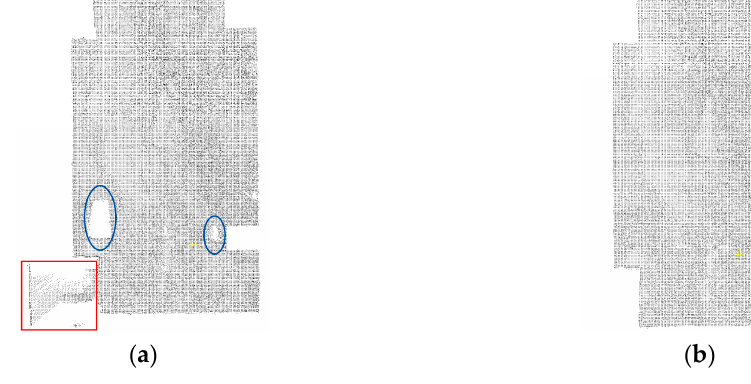
Figure 5. Analysis of the detected floor surface: ( a ) initial detected floor segment (the points in red rectangle are outliers; the holes in blue ellipses are the occlusions of floor), ( b ) final floor segment.